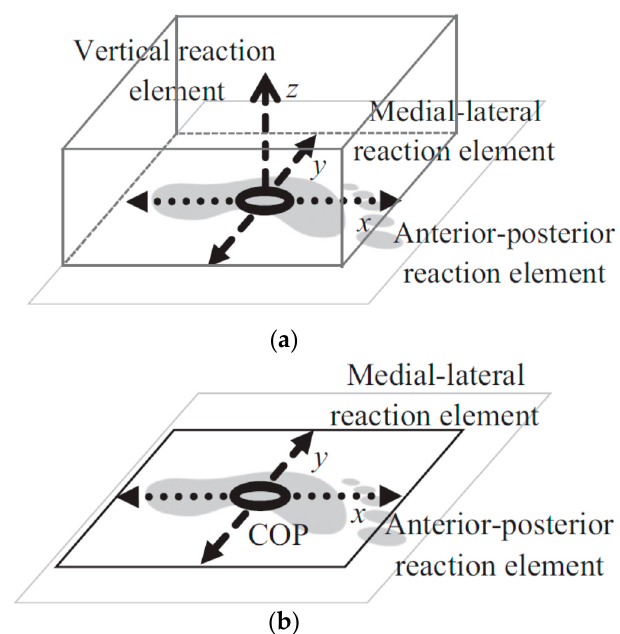
Figure 13 . Force components of the Type-I ( a ) and II ( b ) contact models (after [71]). Figure 13. Force components of the Type-I ( a ) and II ( b ) contact models (after A set of walking tests was carried out with seven healthy male subjects (age: 23 ± 2 years, weight: